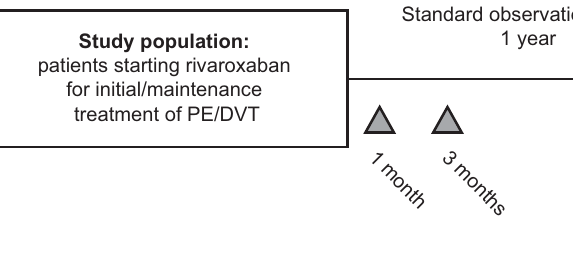
Fig. 1 Design of XASSENT. DVT, deep vein thrombosis; PE, pulmonary